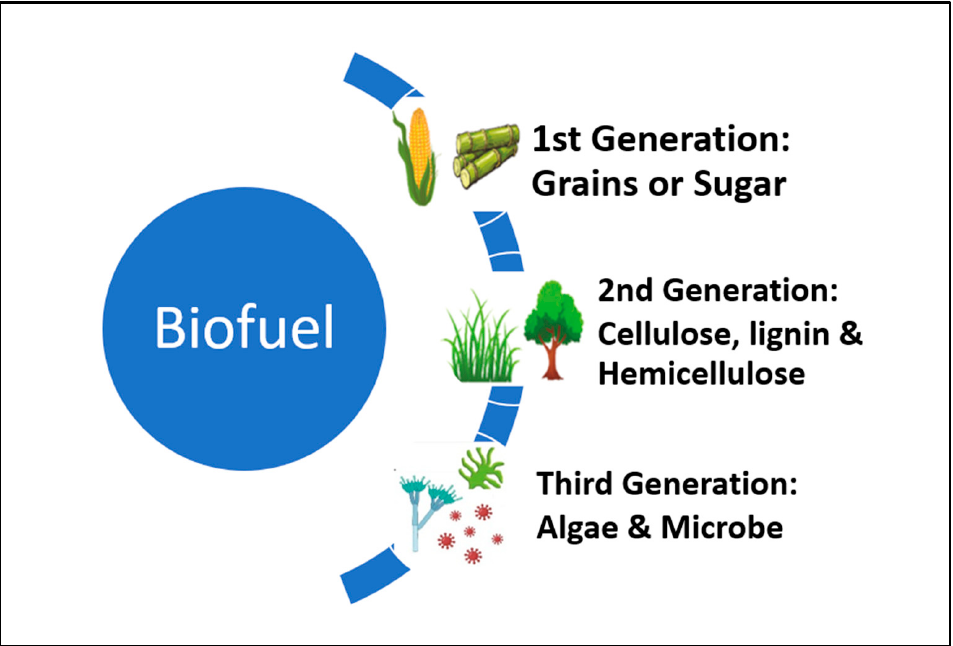
Figure 1. Classification of biofuels according to their generation.